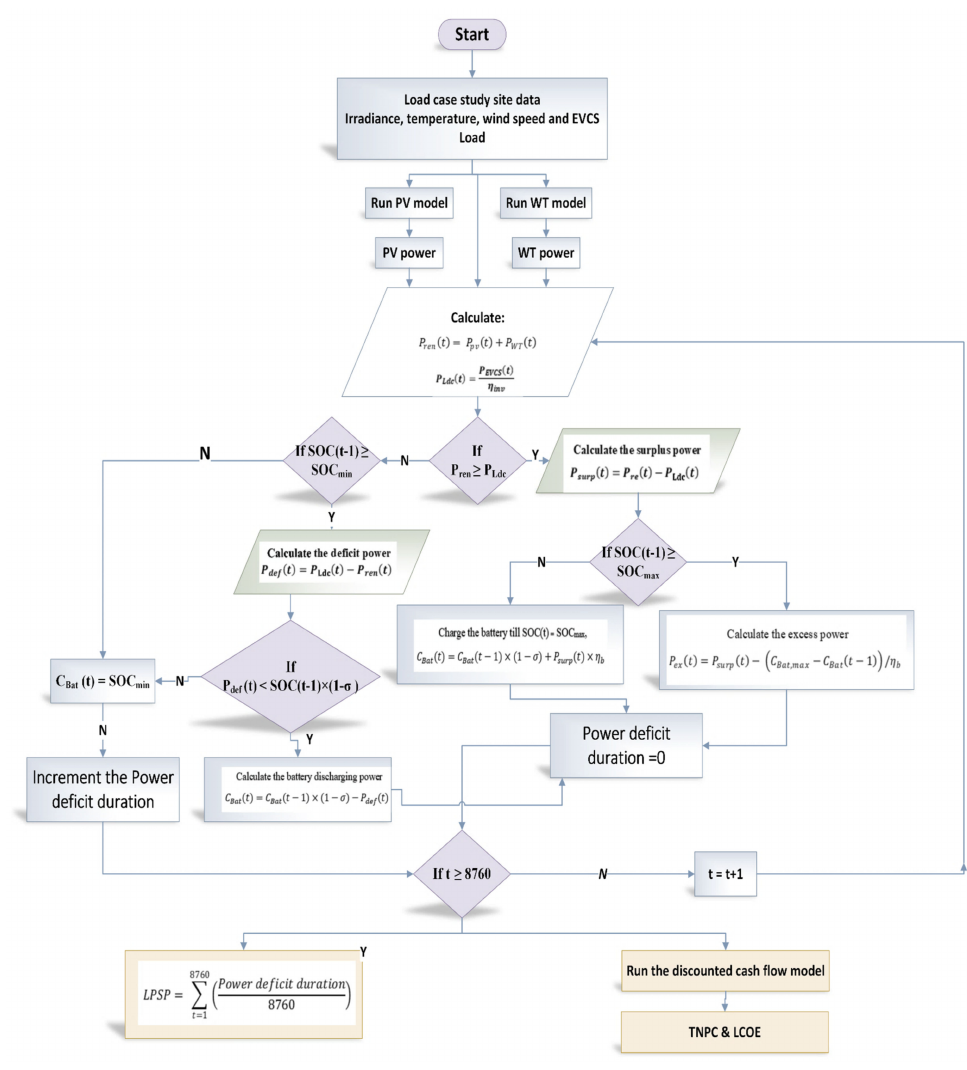
Figure 5. Flowchart of the proposed hybrid